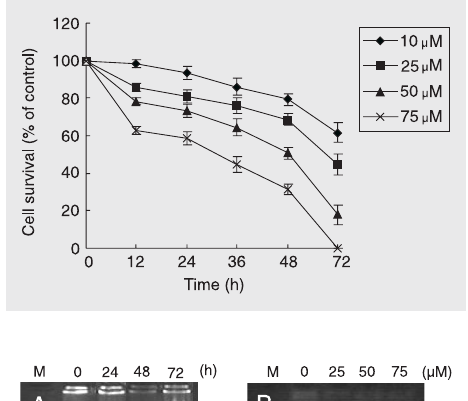
Figure 2. Curcumin induces DNA fragmentation in HT-29 cells. A , Cells were treated with 50 µM curcumin and the control was treated with medium containing an equivalent amount of DMSO with- out curcumin. At the indicated times, the cells were harvested and lysed. DNA fragmentation was examined by agarose gel electro- phoresis. B , Cells were incubated in medium containing curcumin at the indicated concentrations for 48 h. The cells were harvested and lysed. DNA fragmenta- tion was examined by agarose gel electrophoresis. (M: 1 kb DNA